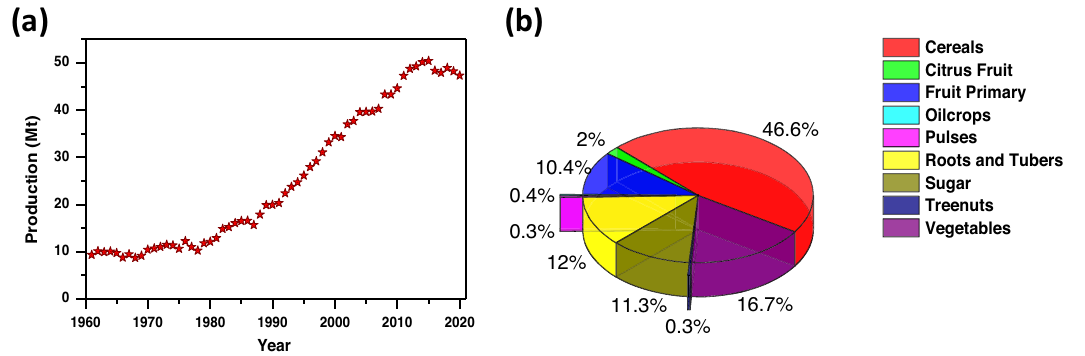
Figure 2: Production of Vietnamese agricultural products as per the FAO system ( a ) and percentage of main agricultural crops in Vietnam ( b ) , data sources are reproduced from the FAO at https://www.fao.org under an open access Creative Common CC BY license.